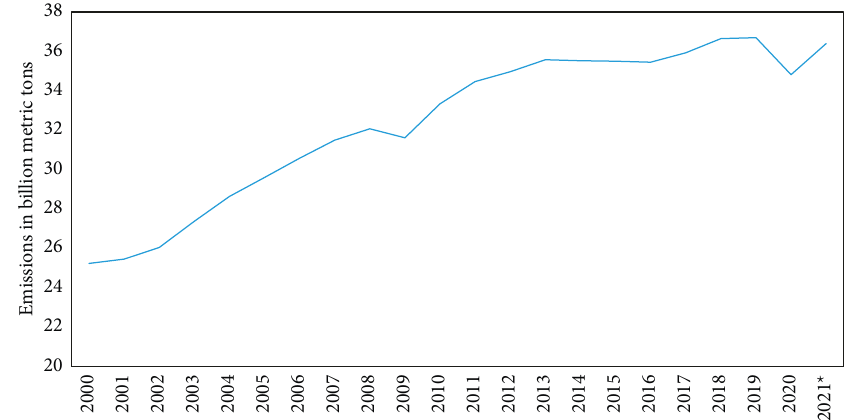
Figure 1: Annual CO 2 emissions worldwide from 2000 to 2020.